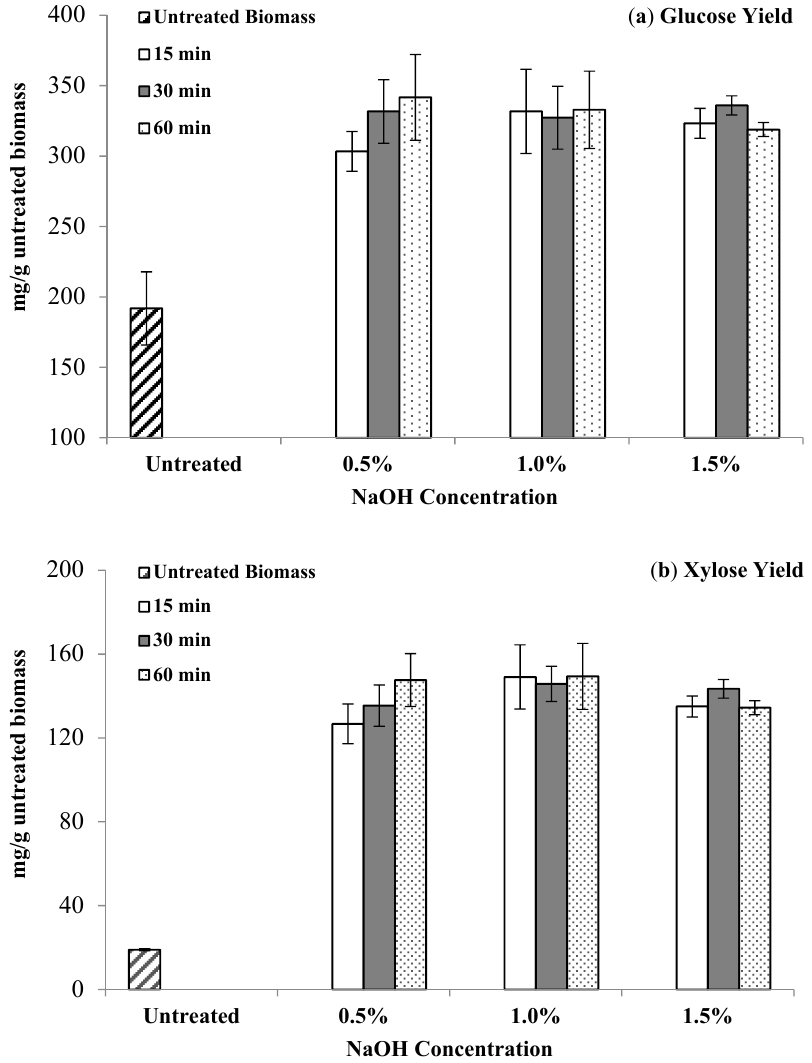
Figure 3. ( a ) Glucose and ( b ) xylose yield after enzymatic hydrolysis of NaOH-pretreated switchgrass. Hydrolysis of untreated switchgrass produced 191.8 mg glucose/g biomass and 19.0 mg xylose/g biomass, which was equivalent to 47.6% and 8.0% of glucan and xylan conversion, respectively. NaOH-pretreated samples produced significantly ( p < 0.05) higher glucose and xylose. Maximum glucose and xylose yields were 341.7 mg glucose/g untreated biomass with 0.5% NaOH for 60 min and 149.4 mg xylose/g untreated biomass with 1.0% NaOH for 60 min, respectively. Overall glucan conversion from all pretreated samples was 75.2–84.7%, and xylan conversion was 53.7% and 63.3%. Because of the extraction of lignin from switchgrass during pretreatment with NaOH, switchgrass